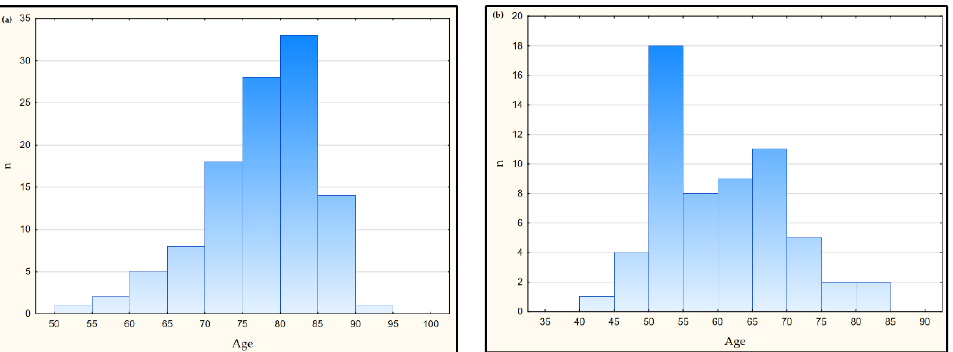
Figure 1. Scatterplot for age in the AD ( a ) and control groups ( b )—statistically significant differences between groups: study group vs. control group (Mann-Whitney U test test), p < 0.001.